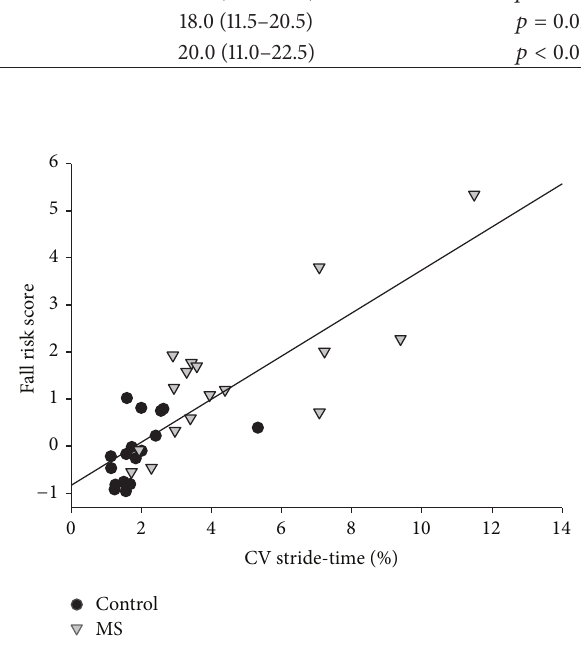
Figure 3: Correlation between CV of stride-time and fall risk in the MS and control